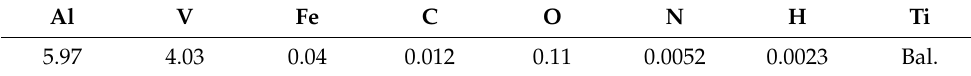
Table 1. Chemical composition of the TC4 alloy (wt.%) in as received condition.